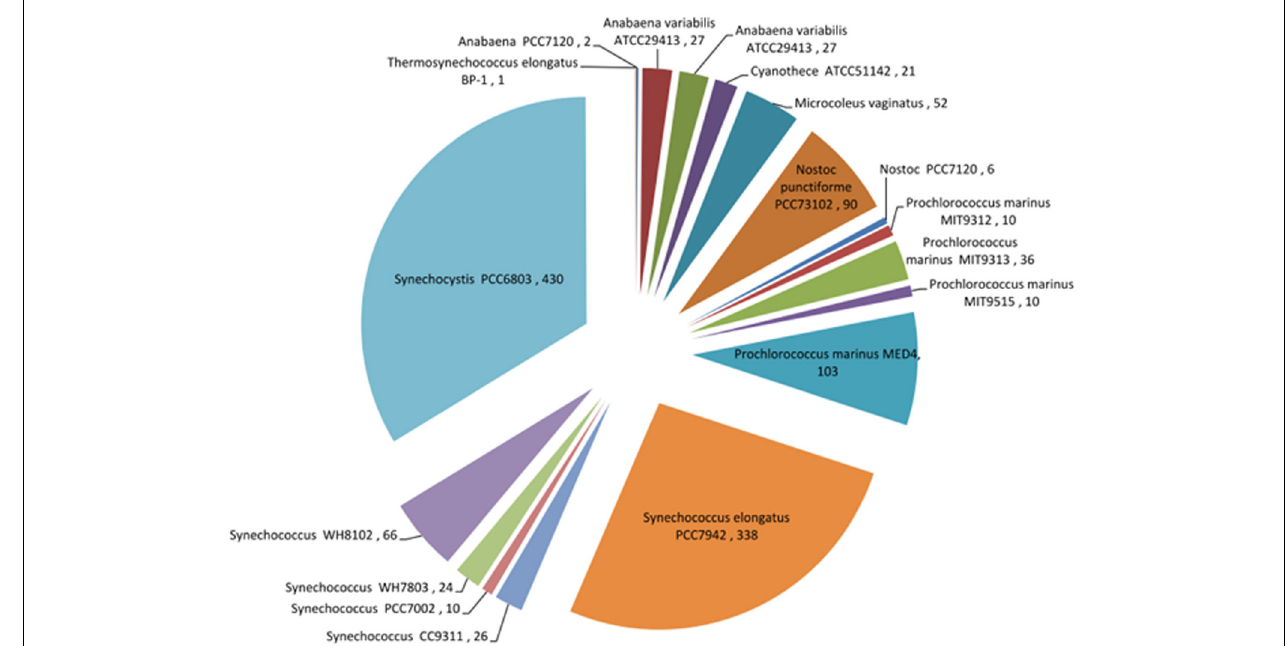
FIGURE 4 | Pie chart showing records of expression data for different cyanobacteria that are currently available in the Gene Expression Omnibus (GEO) database (http://www.ncbi.nlm.nih.gov/geo/).